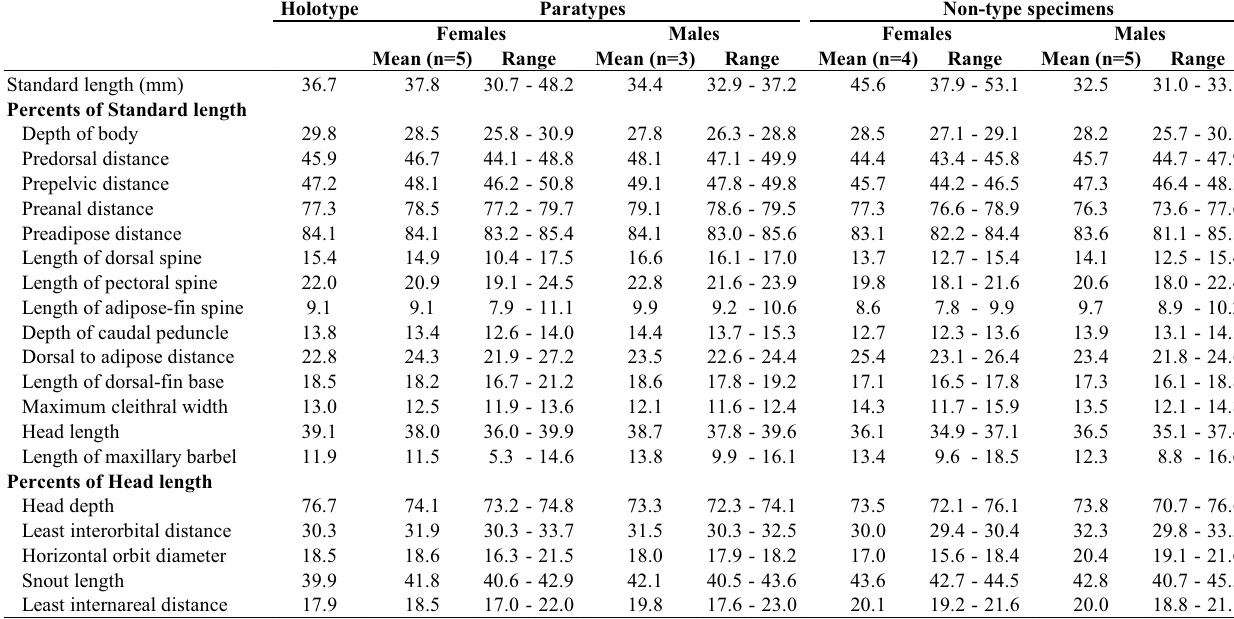
Table 1. Morphometric data of Scleromystax salmacis . Holotype Paratypes Non-type specimens